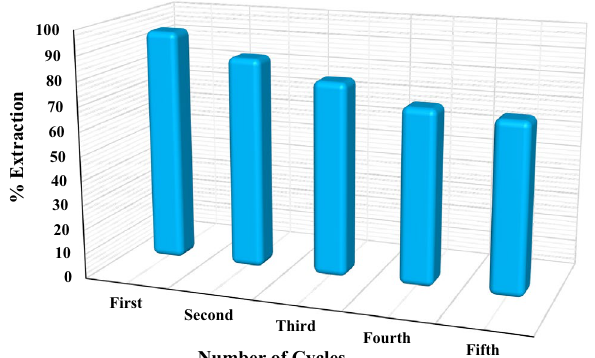
Figure 13. Recycling/reusability of Fe 0.75 Cu 0.25 -BDC@Alg-MoO 3 /GO.